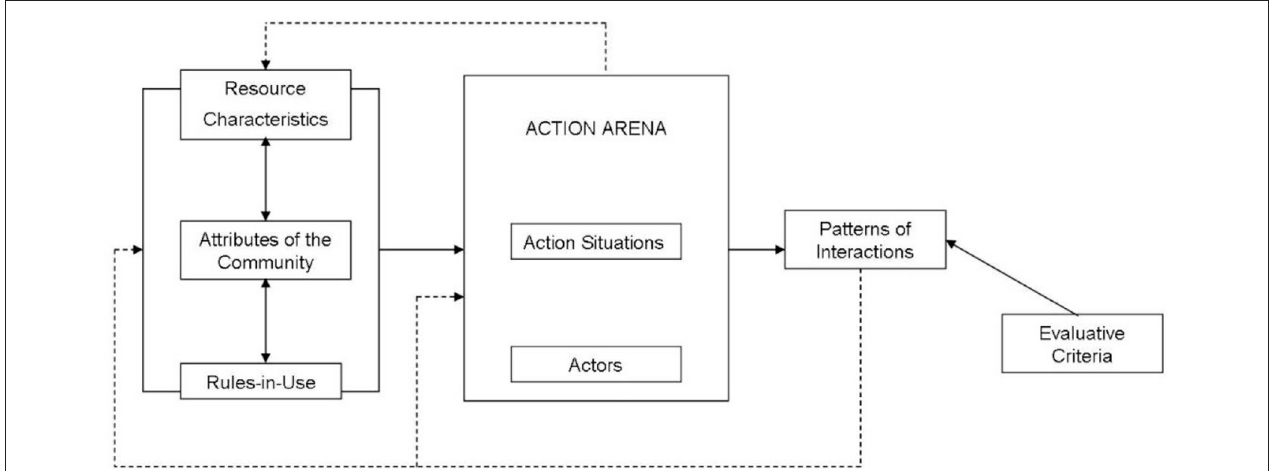
FIGURE 1 | The Governing Knowledge Commons (GKC) Research Framework. Source: Madison et al., 2010.